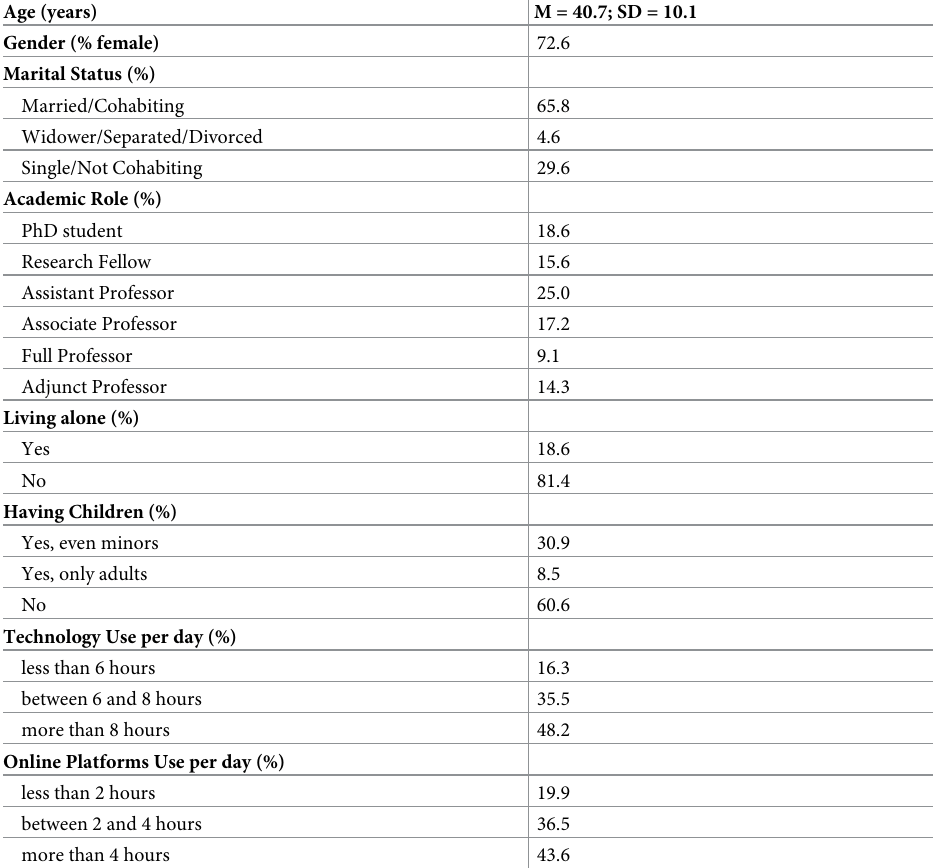
Table 1. Socio-demographic characteristics and use of technology of the sample (N =